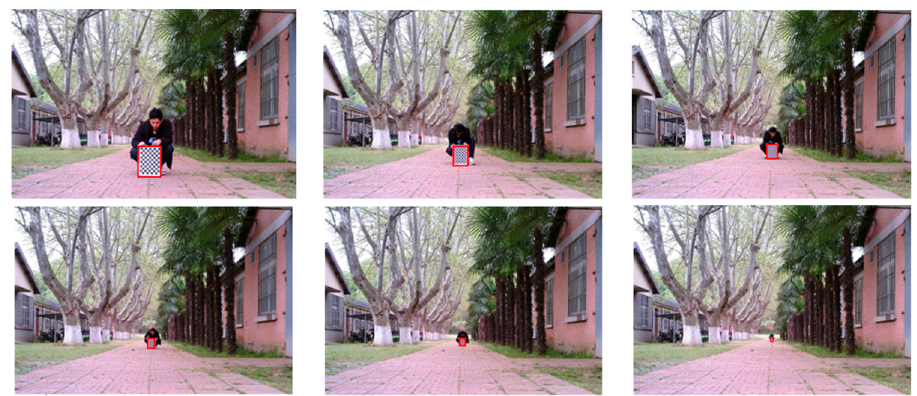
Figure 11. Calibration plate position. By using the curve fitting toolbox of MATLAB, three group of curves with good fitting effects, such as power function, rational function, and exponential function, were obtained by using different fitting functions for 22 sets of data, as shown in Figure 12.